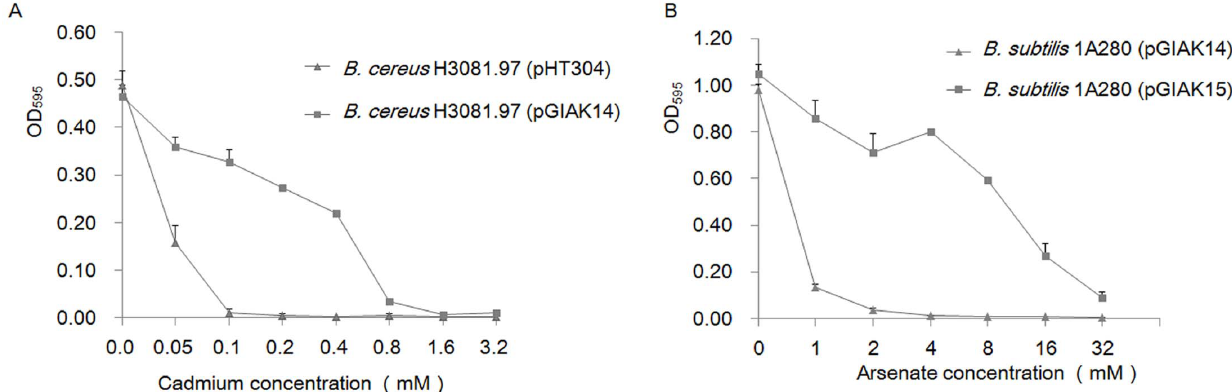
Figure 4. Cadmium and arsenate resistance assays. Cadmium resistance assay (A) was performed in LB medium and arsenate resistance assay (B) was performed in low phosphate medium containing increasing concentrations of Cd 2 + (A) or As 5 + (B). Bacterial growth was measured by optical density at 595 nm after 20 h of growth at 30 u C. Each data point represents the mean value of triplicate cultures. The error bars indicate the standard deviation values. OD 595 , optical density at 595 nm.